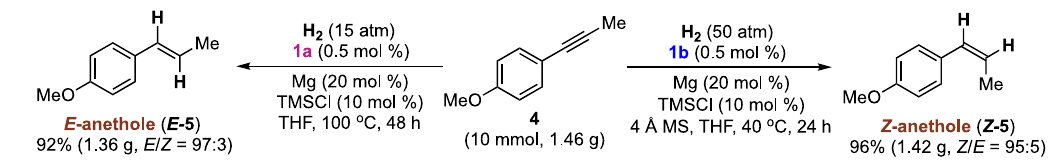
Fig. 5 | Gram-scale hydrogenation and application in the ef fi cient synthesis of both E -and Z -selectiveole fi nderivatives.a Gram-scalehydrogenationinforming food additives. b Gram-scale hydrogenation in forming fragrance-relevant